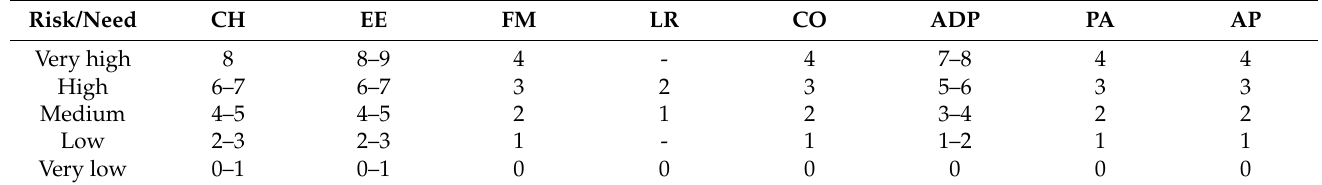
Table 2. Risk/need profile of Level of Service/Case Management Inventory (LS/CMI).